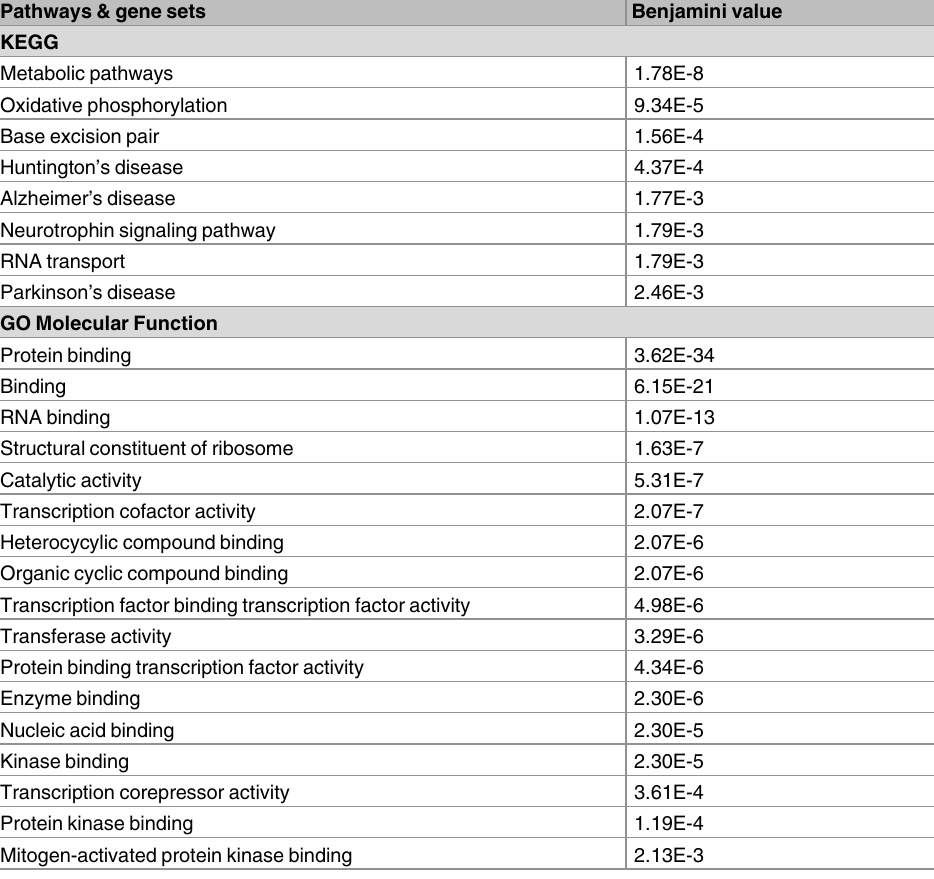
Table 1. Pathways and gene sets enriched in RBM10-only RIP-Seq